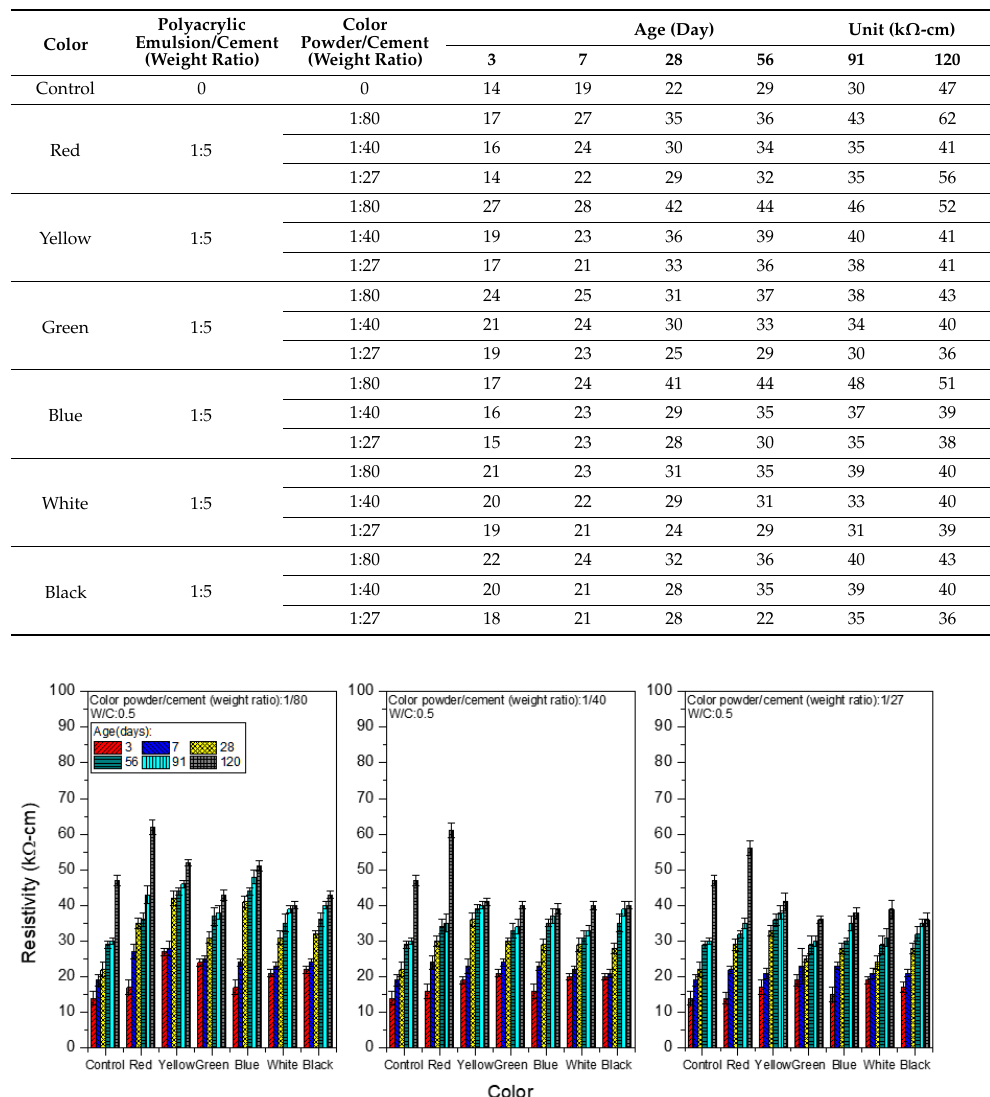
Table 5. Surface electrical resistivity of colored mortar at W/C = 0.5 when weight ratios of color powder/cement at 1:80, 1:40, and 1:27 are added. Polyacrylic Color Age (Day) Emulsion/Cement Powder/Cement Color (Weight Ratio) (Weight Ratio)